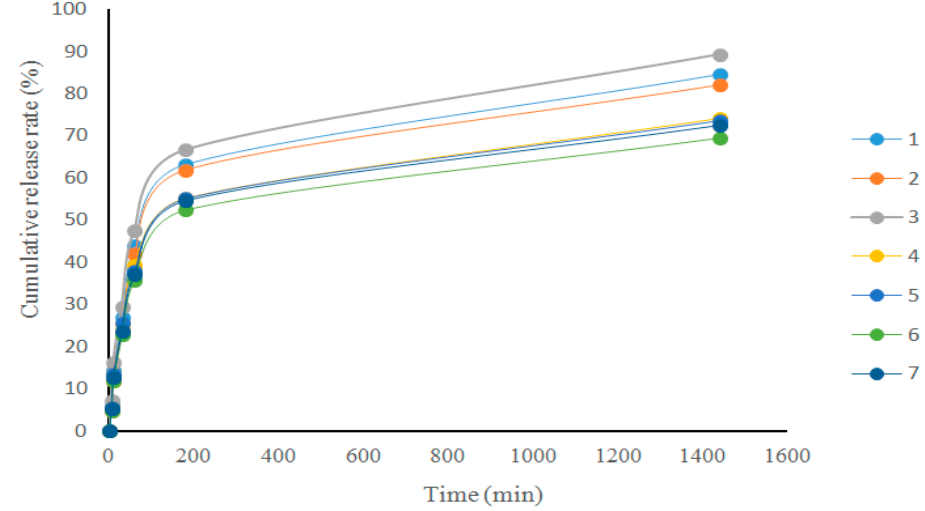
Figure 4. The cumulative release rate of the composite films.